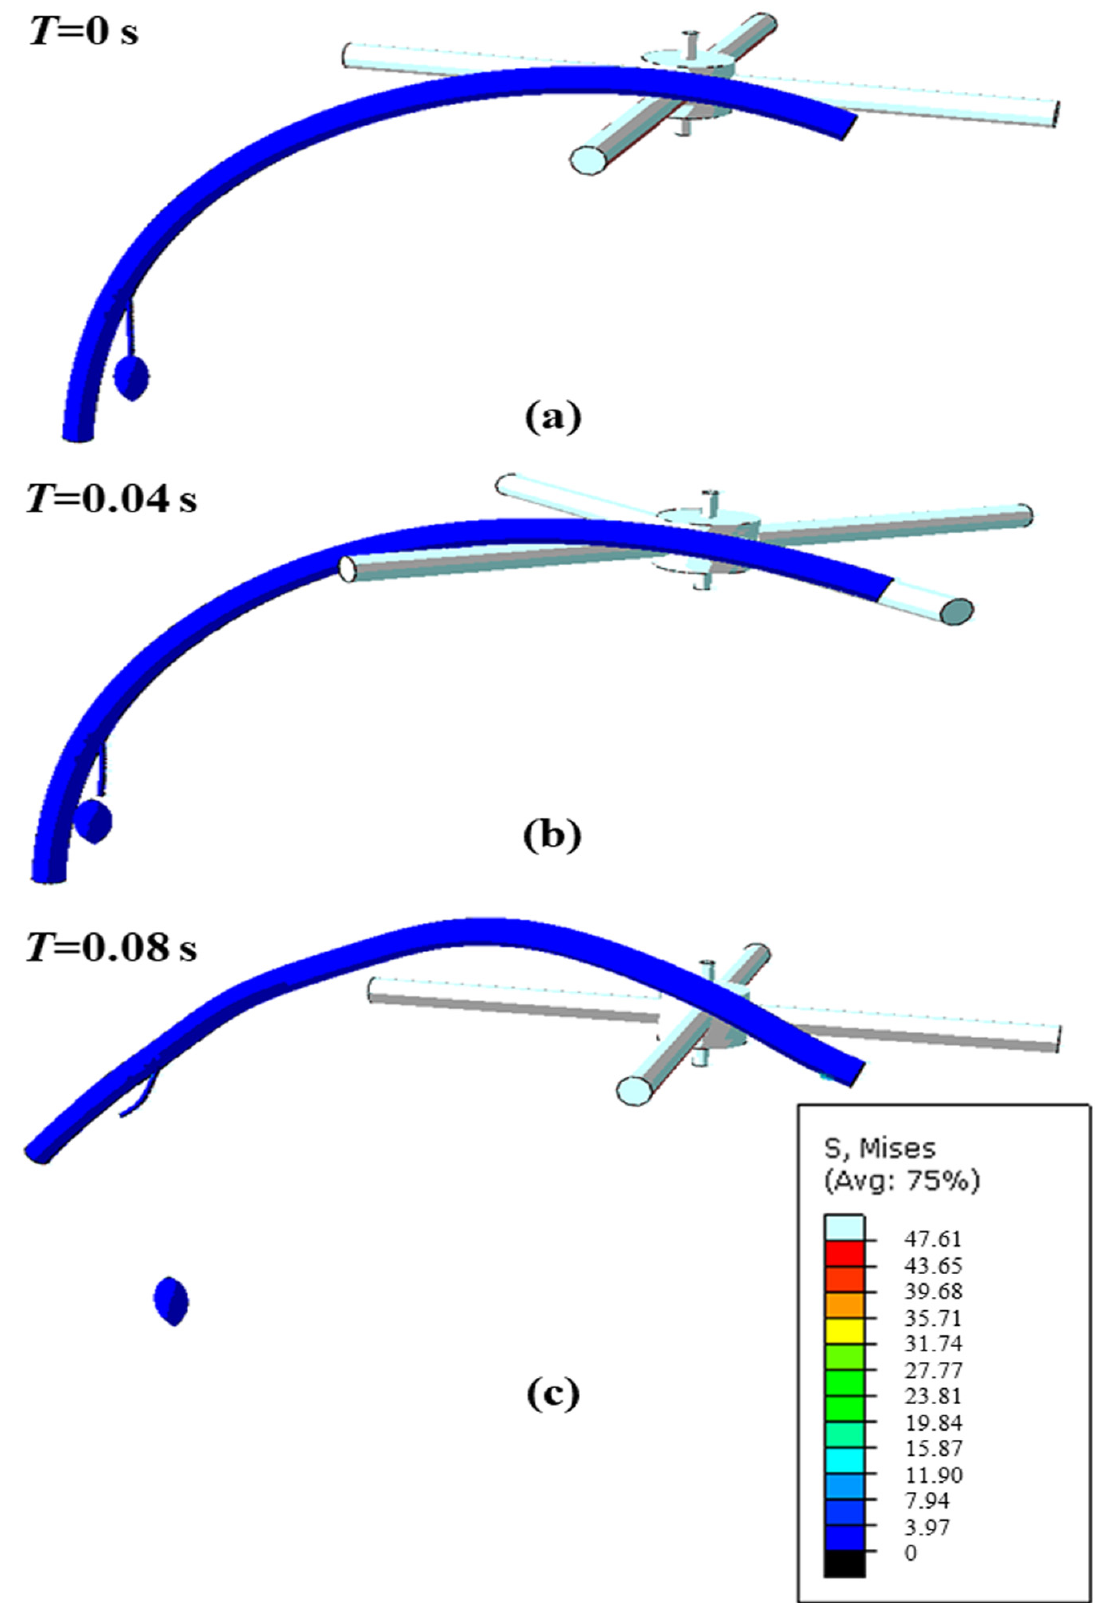
Figure 2. The result of one simulation (the rotating speed was 180 r/min, the material was the silica gel, and the amplitude was 20 mm) at 0 s ( a ), 0.04 s ( b ), and 0.08 s ( c ).